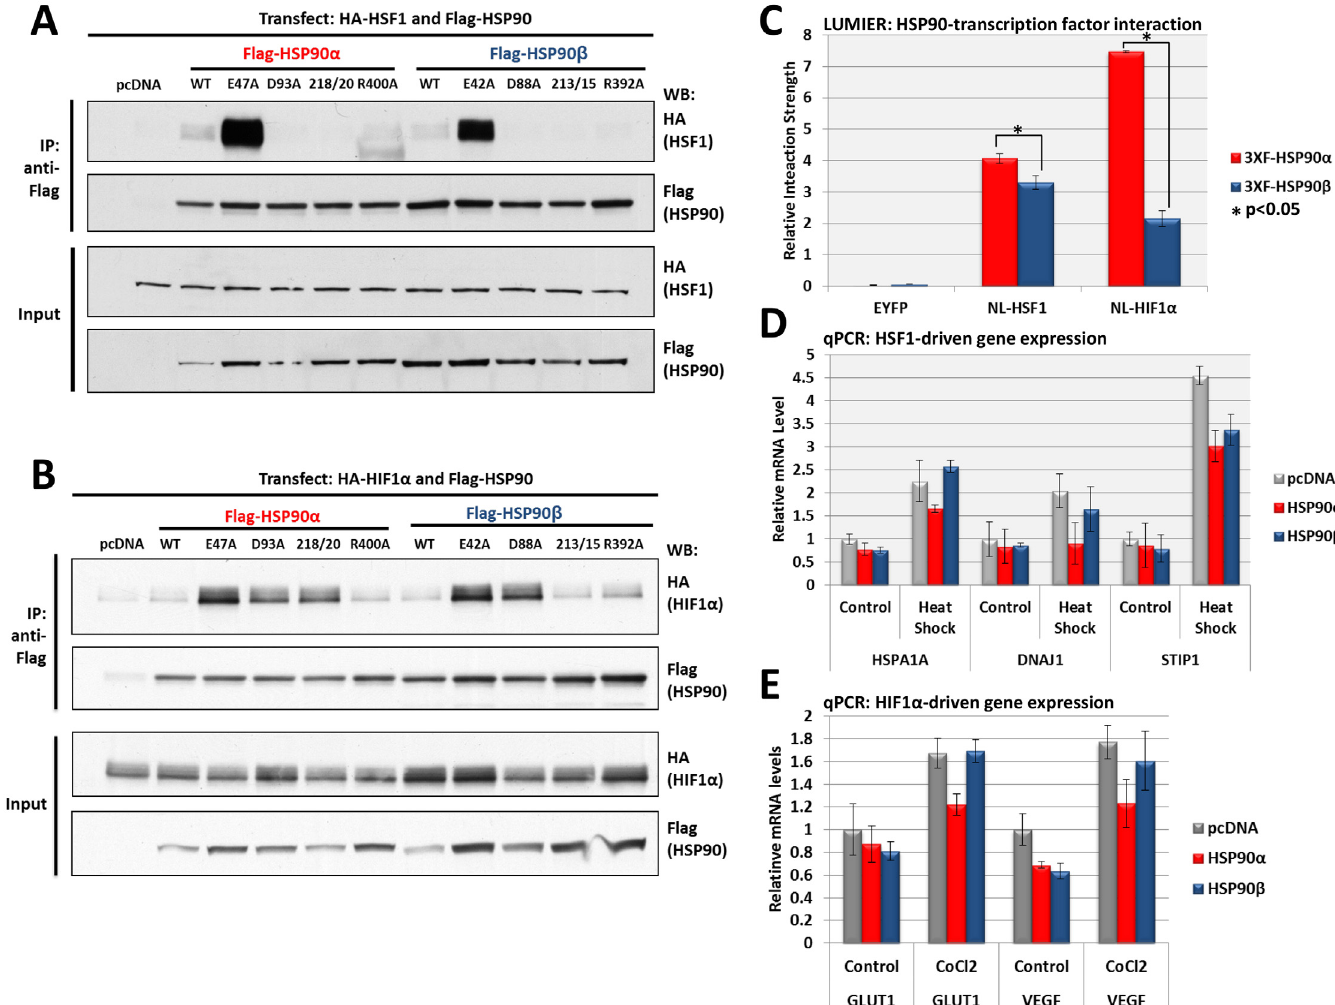
Fig 2. Interaction of HSF1 and HIF1 α with HSP90 isoforms. (A) HSF1 interaction with HSP90 WT and mutants: HEK293 cells were transfected with HA-HSF1 and each FLAG-HSP90 construct, harvested, immunoprecipitated with anti-FLAG beads and western blotted for HSF1 interaction. Input lysates were normalized and run as controls. (B) HIF1 α interaction with HSP90 WT and mutants: HEK293 cells were transfected with HA-HIF1 α and each FLAG-HSP90 construct, harvested, immunoprecipitated with anti-FLAG beads and western blotted for HIF1 α interaction. Input lysates were normalized and run as controls. (D) Measurement of the relative interaction strength of HSF1 and HIF1 α with each HSP90 isoform by LUMIER: HEK293 cells transfected with HSF1 or HIF1 α and each HSP90 isoform were harvested, applied to a 96-well anti-FLAG plate and assayed for luciferase activity. The difference in relative interaction strength of HSP90 α and HSP90 β for HIF1 α ( > 3-fold) was statistically significant (p < 0.05); the difference in relative interaction strength for HSF1, while much less, was also statistically significant (p < 0.05) (see Methods). (E) Effect of each HSP90 isoform on heat shock induced gene expression: HEK293 transfected with each HSP90 isoform were heat shocked at 42°C for 30 minutes, allowed to recover for 2 hours, then harvested and assayed by qPCR for HSPA1A , DNAJ1 and STIP1 expression. (F) Effect of each HSP90 isoform on hypoxia-induced gene expression: HEK293 cells transfected with each HSP90 isoform were treated with 100 μ M CoCl 2 for 2 hours, harvested and assayed by qPCR for SLC2A1 and VEGFA